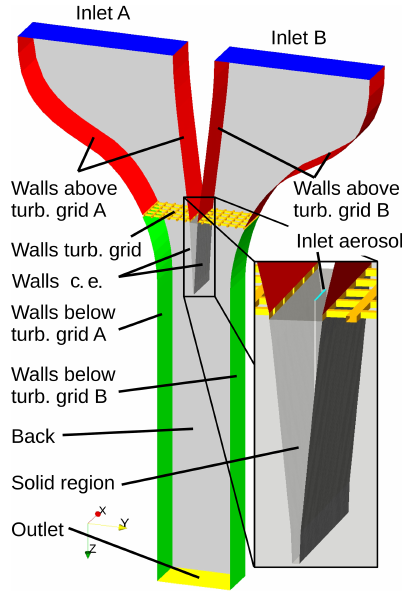
Figure 3. Boundaries of the computational domain with detailed view of the aerosol inlet region between the two airflow branches (c.e. stands for cutting